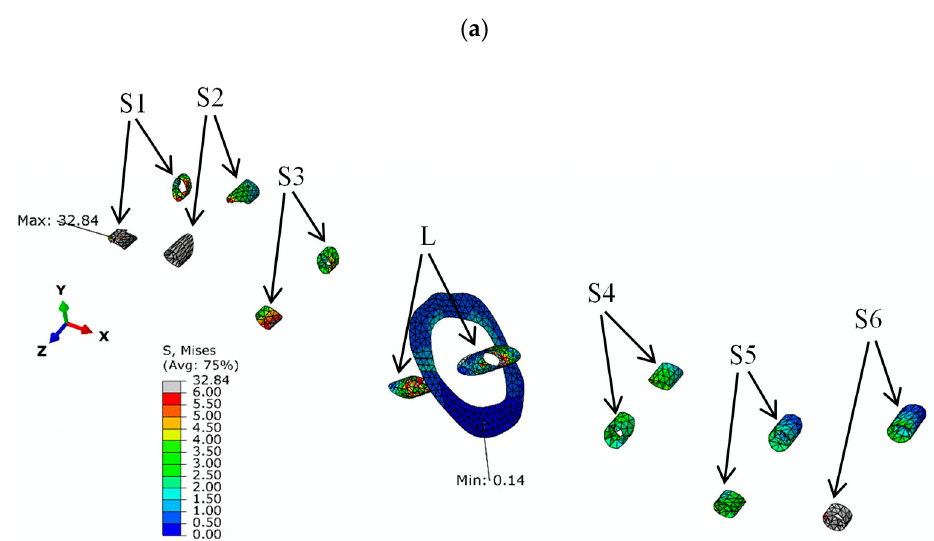
Figure 15. ( a ) Identification of the elements selected for stress analysis; ( b ) von Mises stresses at the seven screws (S1–S6 and the lag screw: L) and at the oblique fracture surface.